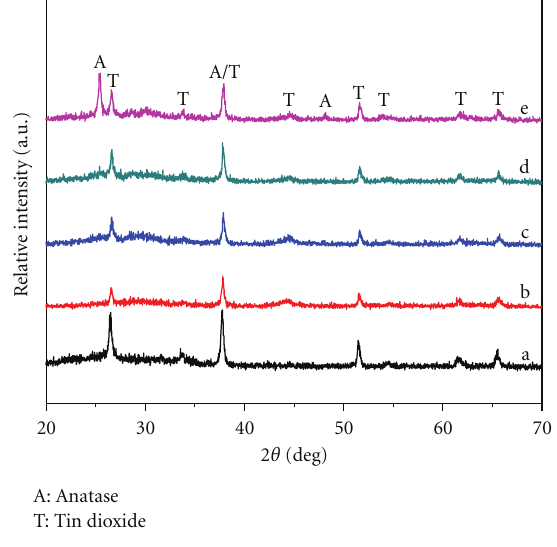
Figure 3: XRD patterns of (a) the substrate and the TNR/SnO 2 films calcined at (b) 300, (c) 400, (d) 500, and (e) 600 ◦ C.